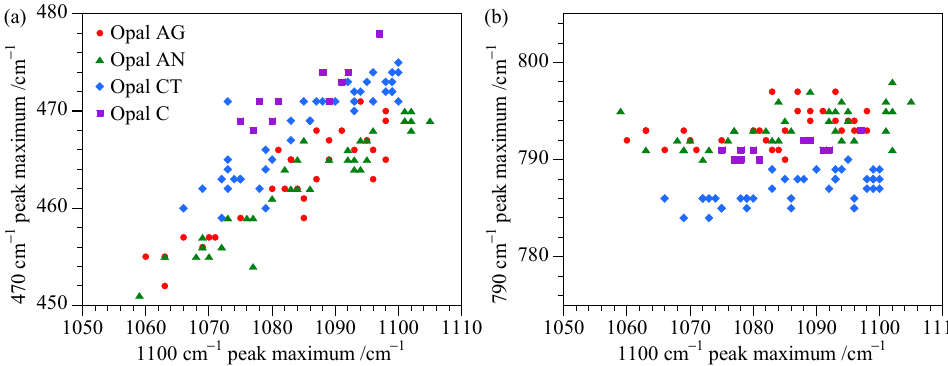
Figure 11. Correlation of peak positions for the powder ATR spectra: ( a ) 470 and 1100 cm − 1 peaks and ( b ) the 790 and 1100 cm − 1 peaks. Peak positions are taken from spectra that have been depth corrected.